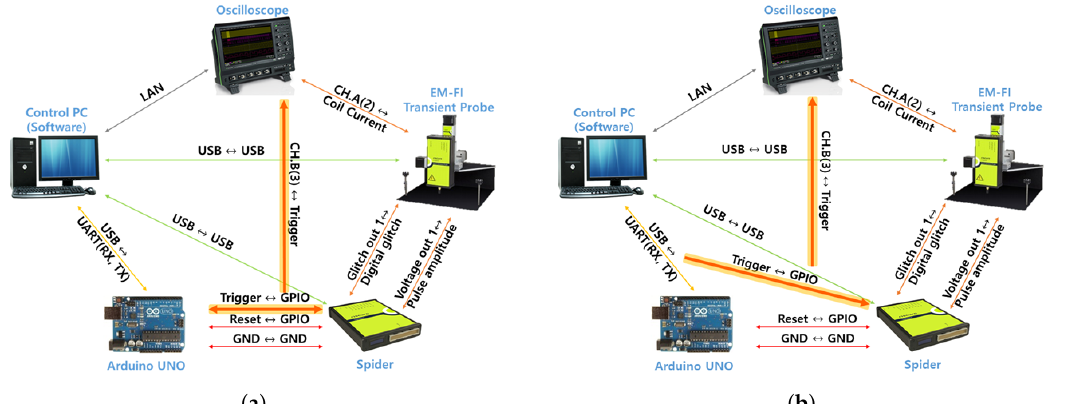
Figure 4. System configuration diagram of ( a ) the conventional fault injection attack system, ( b ) the proposed fault injection attack